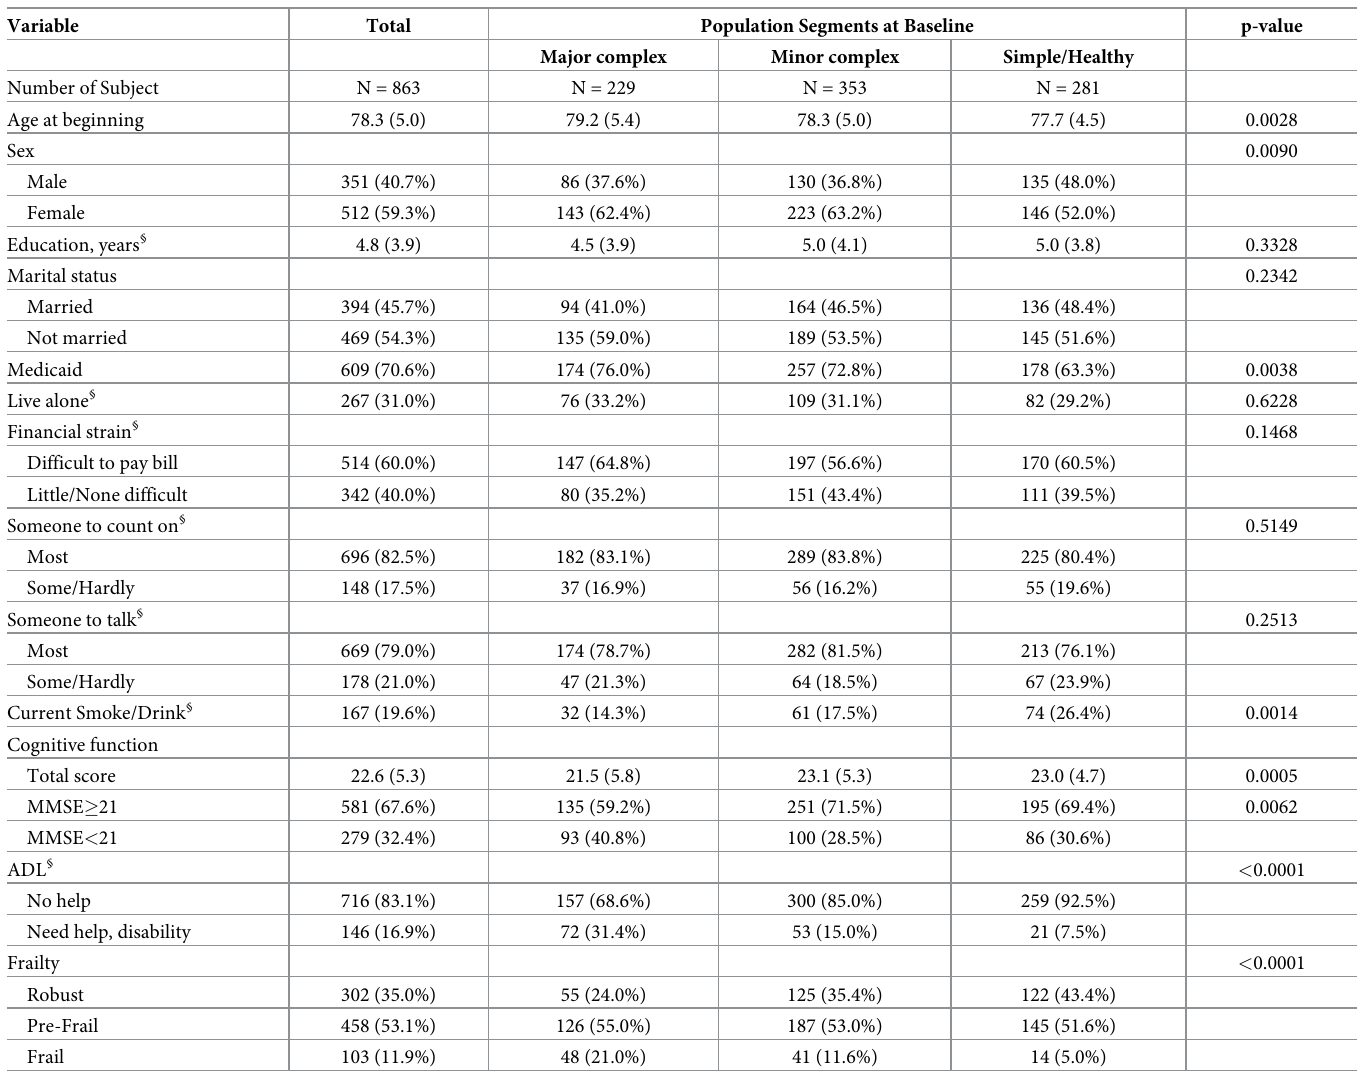
Table 1. Baseline characteristics stratified by population segments (N =